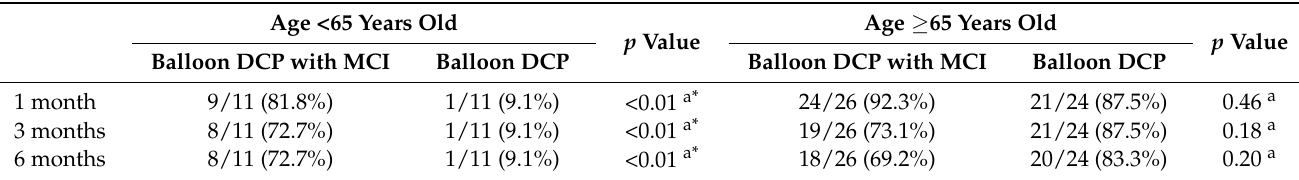
Table 4. Postoperative surgical success rate in patients in balloon DCP combined with pushed-type MCI group and balloon DCP alone group for patients younger than 65 years old and aged at least 65 years